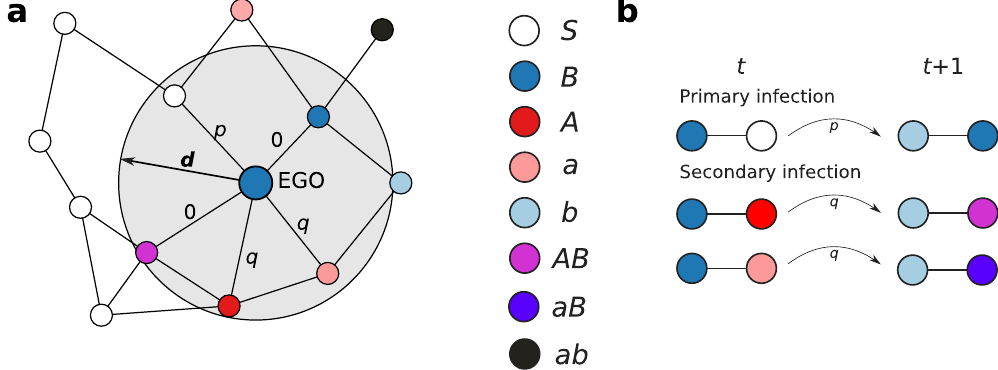
Figure 1. Scheme of the model. ( a ) Contagion of infection  from EGO to its neighbors (particles at a distance smaller than d ). Labels on the links indicate the infection probabilities. ( b ) Dynamics of primary and secondary infections, happening with probabilities p and q ,